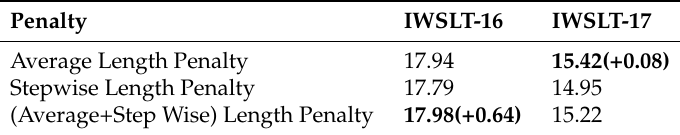
Table 6. Experimental results according to length